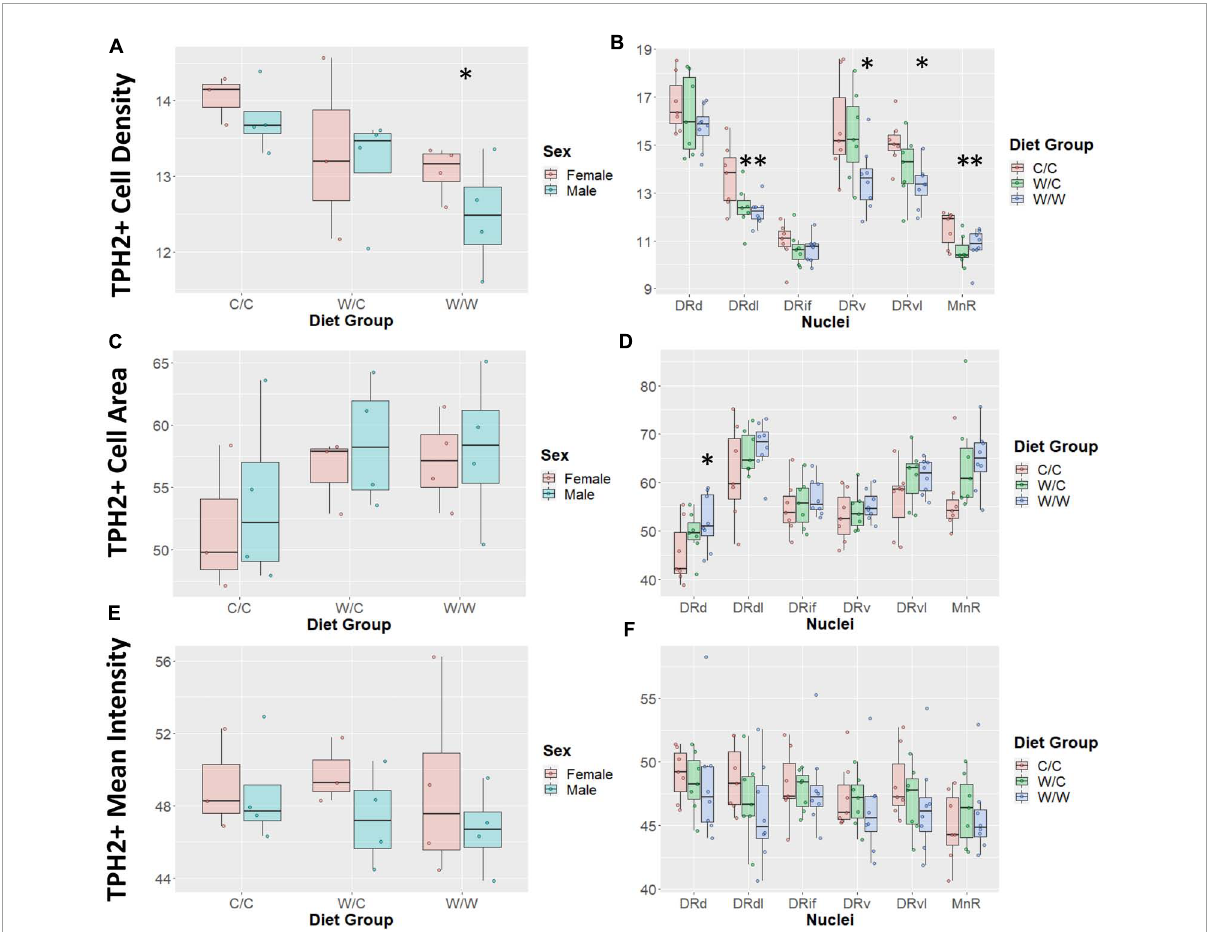
FIGURE4 Western-style diet (WSD) influences raphe tryptophan hydroxylase 2+ (TPH2+) cell outcomes. Data are expressed as box plots with boxes indicating the 1st–3rd quartile range and the median expressed as the horizontal bold line. Asterisks indicate significant differences compared to C/C groups. (A) TPH2 cell count was decreased by perinatal exposure to WSD. The W/W group was decreased compared to the C/C and W/C groups. (B) TPH2 cell number in specific regions appear to be uniquely impacted by perinatal WSD. The DRd and DRif appears not to be impacted, while the DRdl and MnR subregions both the W/C ( p < 0.05) and W/W ( p < 0.05) groups were reduced compared to the C/C group. Additionally, in the DRv and DRvl subregions only the W/W was reduced compared to the C/C group ( p < 0.05). While the W/C group was not significantly different from the C/C group, it did trend in the same direction as the W/W group. (C) TPH2 cell area was not found to be significantly different between diet groups. (D) TPH2 cell area was only significantly increased in the DRd subregion ( p < 0.05). (E) TPH2 mean intensity per image was not found to be significantly different between diet groups. (F) TPH2 mean intensity per image was not found to be significantly different in any specific subregions. DRd, dorsal nucleus of the dorsal raphe; DRdl, dorsolateral nucleus of the dorsal raphe; DRv, ventral nucleus of the dorsal raphe; DRvl, ventrolateral nucleus of the dorsal raphe; MnR, median raphe nucleus.